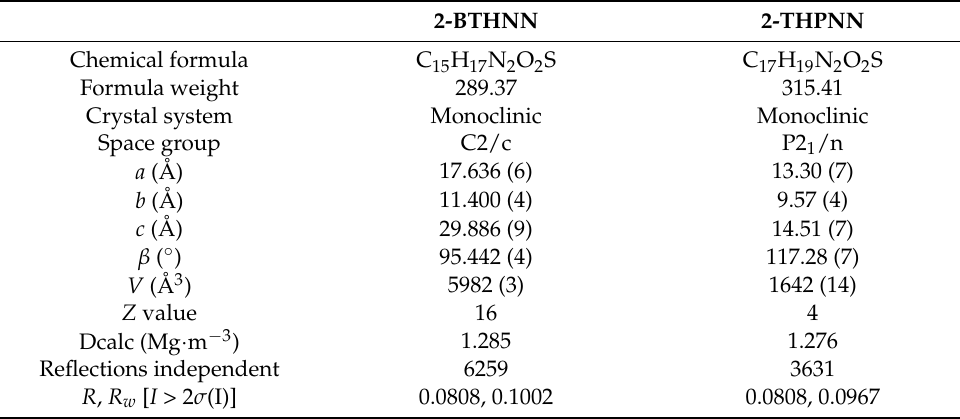
Table 1. Crystallographic data for the organic radicals 2-BTHNN and 2-THPNN. 2-BTHNN Chemical